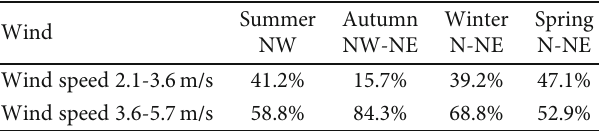
Table 1: Statistics of wind speed based on 1995-2013 data [20].